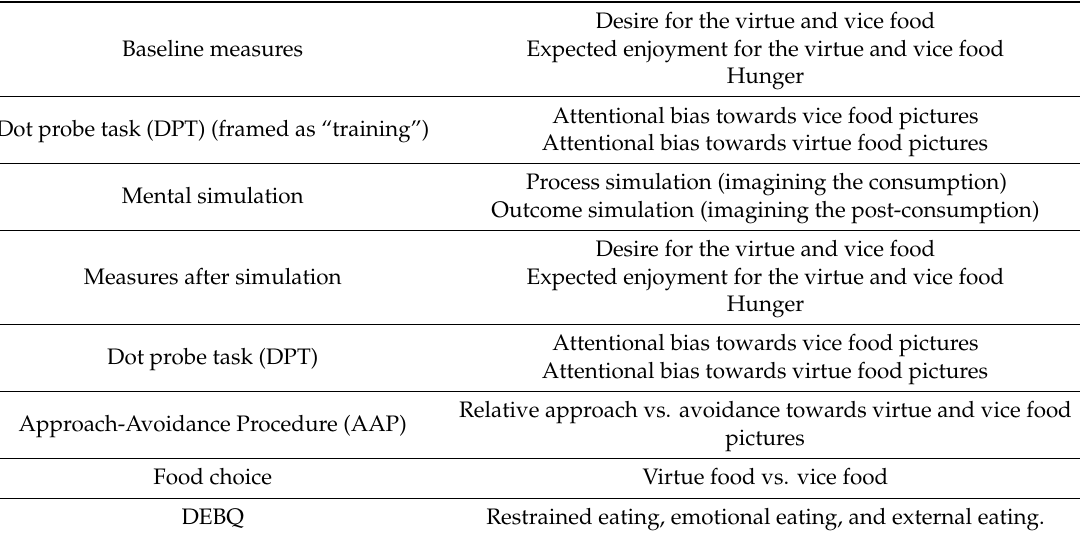
Table 1. Variables involved in the experimental procedure in chronological